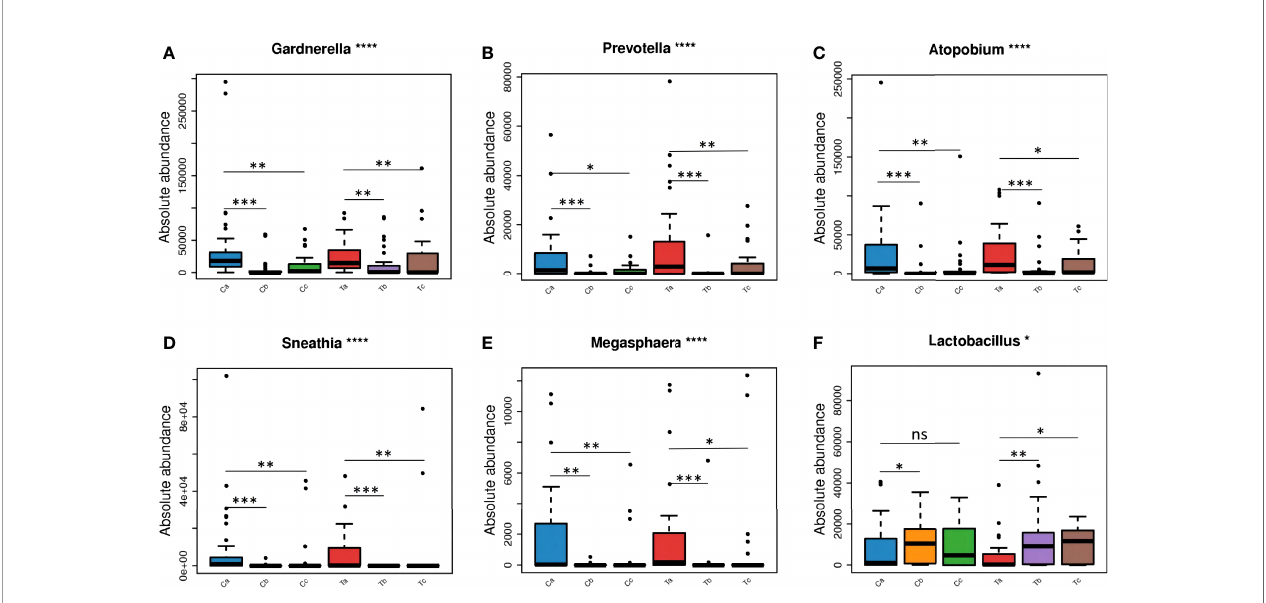
FIGURE 5 | The changes of dominant microorganisms between the two groups at each visit: Gardnerella (A) , Prevotella (B) , Atopobium (C) , Sneathia (D) , Megasphaera (E) , and Lactobacillus (F) . (Ta, Tb, and Tc represent stages V1, V2, and V3 of the Furong group, respectively; Ca, Cb, and Cc represent stages V1, V2, and V3 of the Clindamycin group, respectively; ns, nonsense; *0.01 ≤ P value < 0.05; **0.001 ≤ P value < 0.01; *** 0.0001 ≤ P value < 0.001; ****P value <